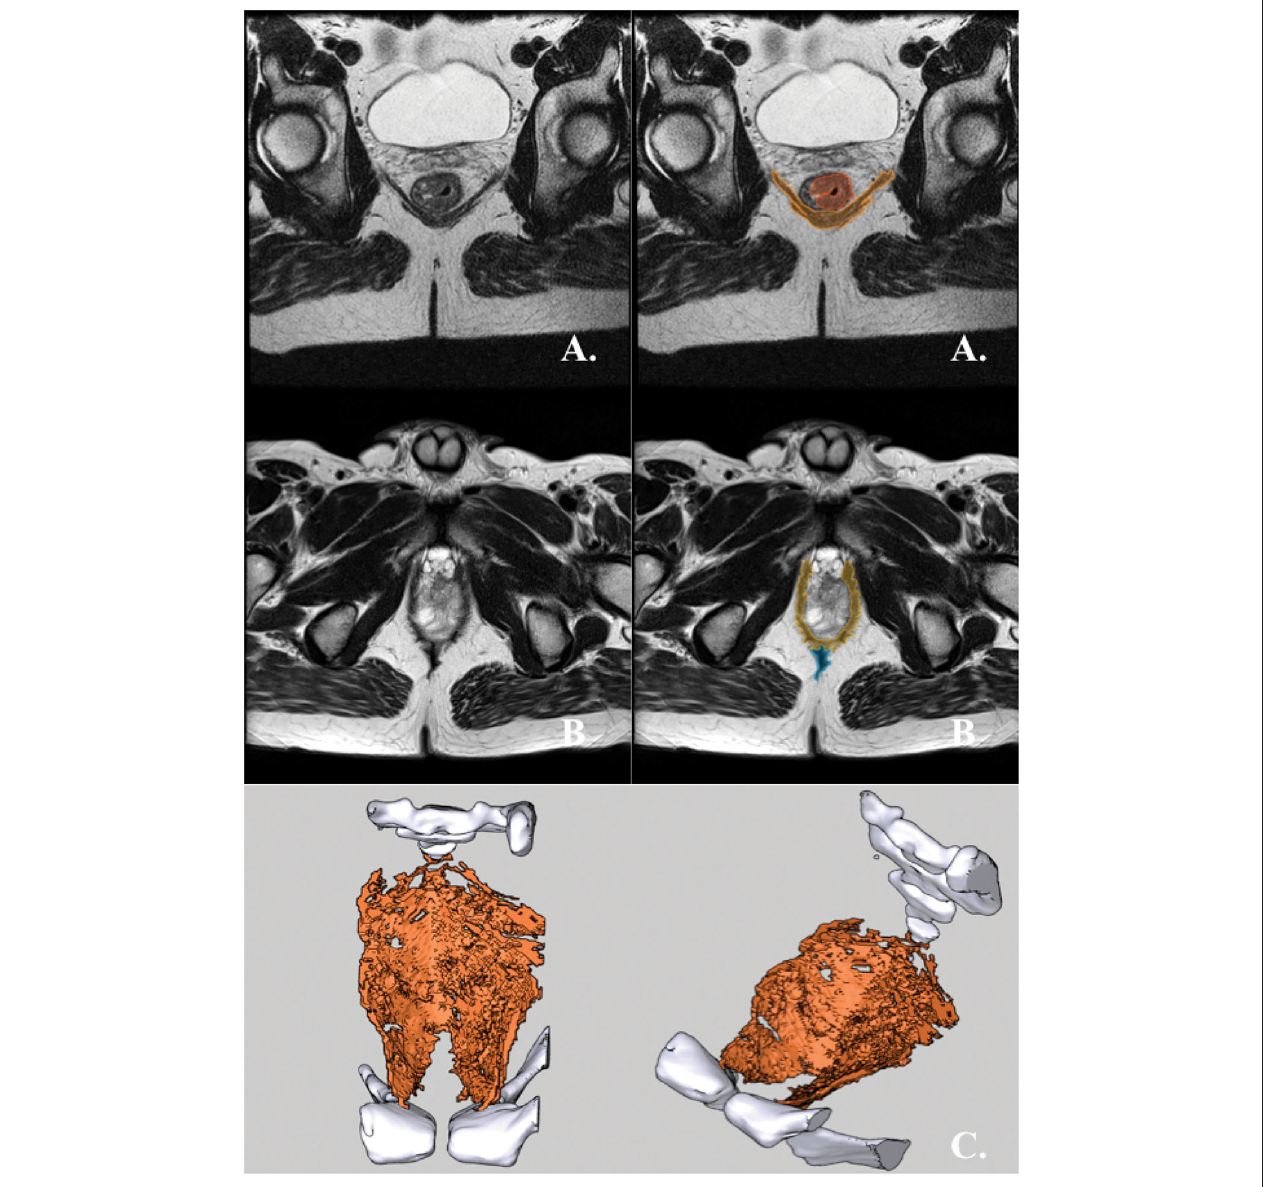
FIGURE 4 | c-APE. (A) Preoperative axial T2-weighted MRI of a rectal cancer patient with an mrT3-tumor with invasive growth between 2 and 4 o’clock. RPD is hatched in orange. The tumor is hatched in red. (B) Postoperative axial T2-weighted MRI of the same patient after cAPE. RPD is hatched in orange. Cicatrice is hatched in blue. (C) The RPD of the same patient, 3D-rendered and shown in superior and antero-lateral superior views. The rendering is made from the above postoperative MRI. The bony pelvis is rendered in white, while RPD is rendered in orange. No bio-mesh was used for supporting the closure of the defect in the pelvic